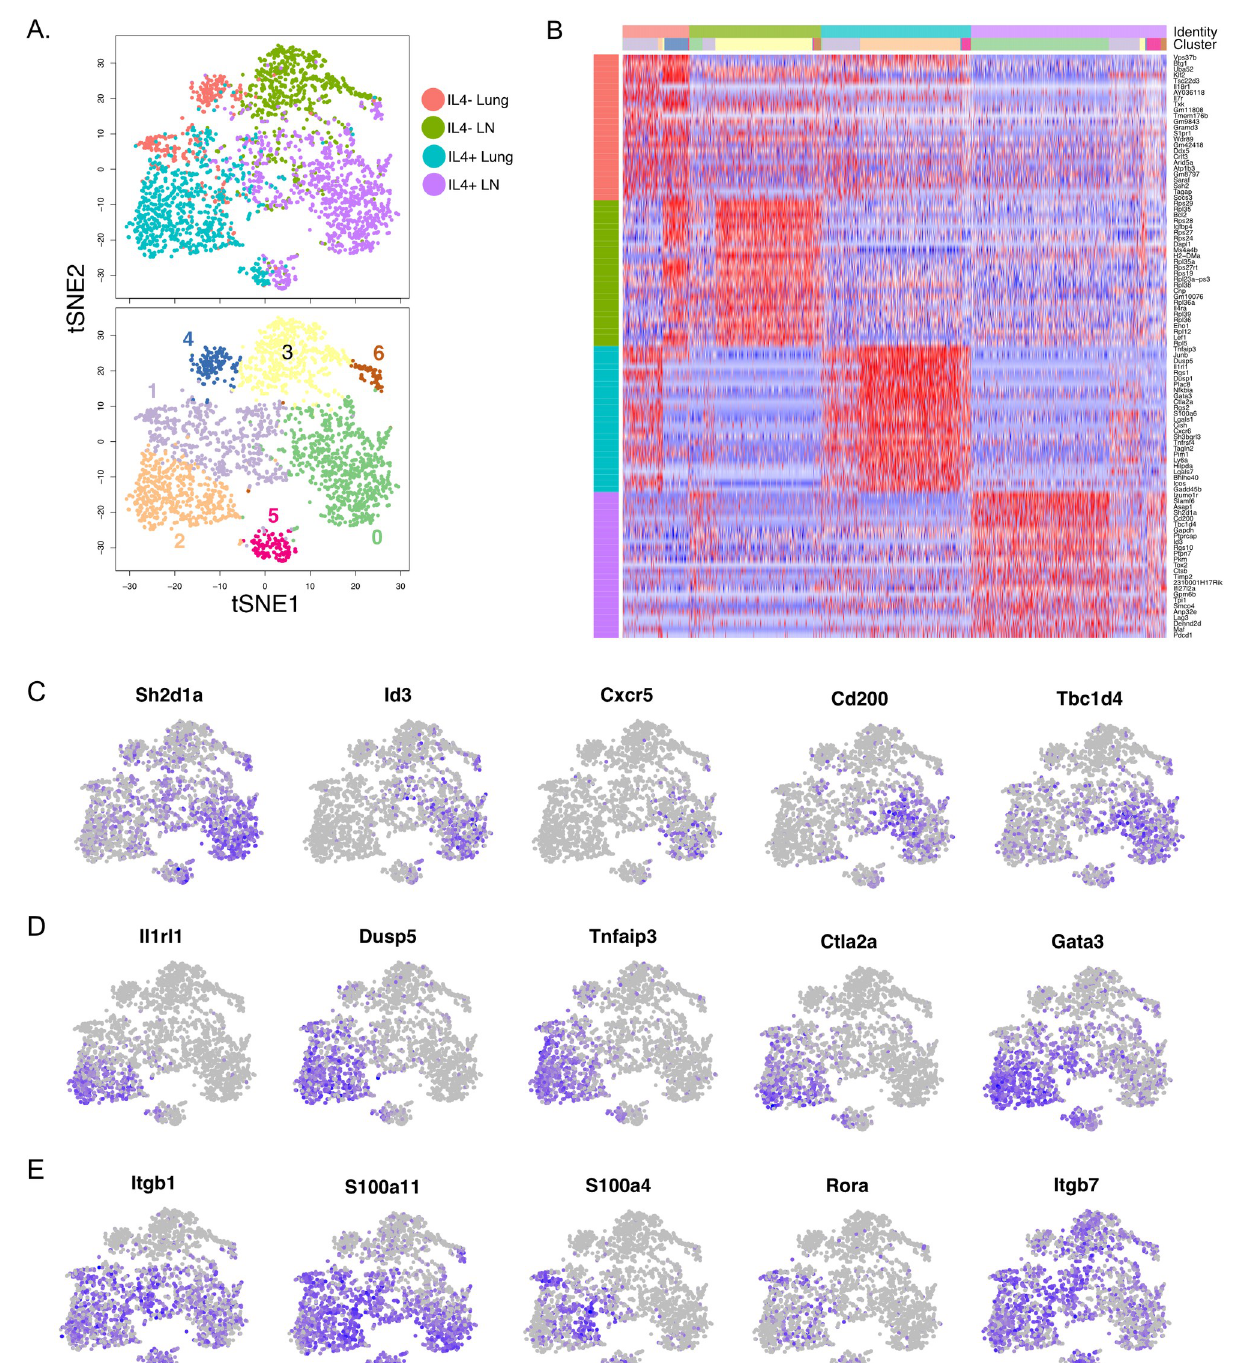
Fig 7. Single-cell sequencing reveals three distinct IL-4-expressing CD4 + T cell populations in the lymph nodes and lung. GFP + and GFP - CD4 + T cells from the lung and mediastinal lymph nodes harvested for one of the bulk RNA-sequencings was split and processed for single-cell RNA-seq analysis. (A) t-SNE analysis (Padj < 0.05) between GFP + and GFP - CD4 + T cells in the lung and mediastinal lymph node. Top plot: colors represent the four individual cell types isolated from the indicated tissues and each dot represents an individual cell. Bottom plot: unbiased k-nearest neighbor clustering was performed to identify six unique clusters. (B) Heatmap comparing the top 25 differentially expressed genes within each indicated CD4 + cell population with clusters designated by colors indicated in (A). (C) t-SNE analysis showing the relative expression of genes from cluster 0 (Tfh-like). ( D ) t-SNE analysis showing the relative expression of genes from cluster 2 (Th2-like). ( E ) t-SNE analysis showing the relative expression of genes from cluster 1 (shared between lymph node and lung; transitional).